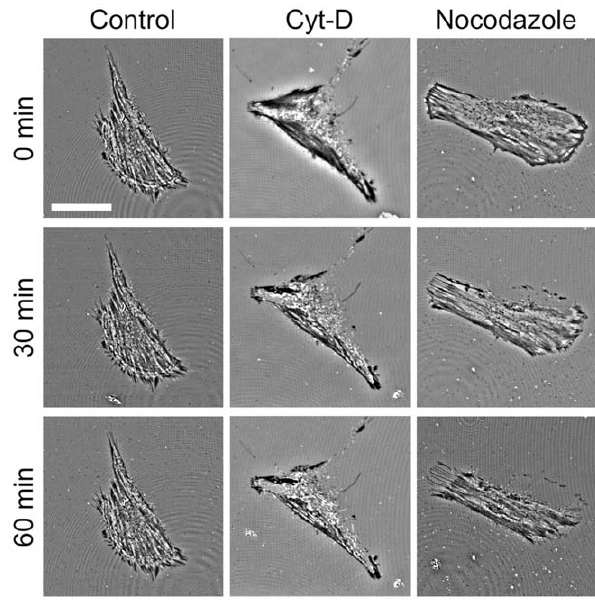
Figure 2. Time-lapse IRM imaging on inhibitor treated C2C12 cells. IRM time-lapse imaging on C2C12 cells before, during and after a 60 min exposure to Cyt-D and nocodazole in comparison to control cells (scale bar=20 m m and applies to all images). Cells treated with Cyt-D and nocodazole display decrease in the dark regions of the cell over the course of 60 mins. The control cells exhibit no change in the low intensity regions of the cell. ML-7 and Y-27632 treatments (data not shown) displayed similar trends as those shown for the Cyt-D and nocodazole treatments. Scale bar=20 m m and applies to all images.